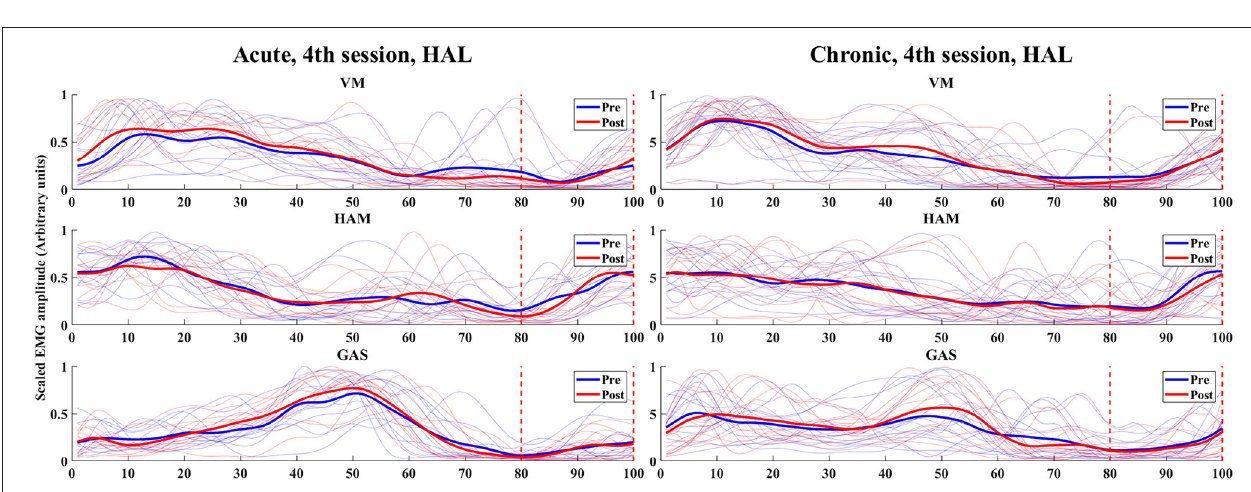
FIGURE 5 | EMG (VM, HAM, and GAS) of acute and chronic stage patients, pre and post 4th HAL